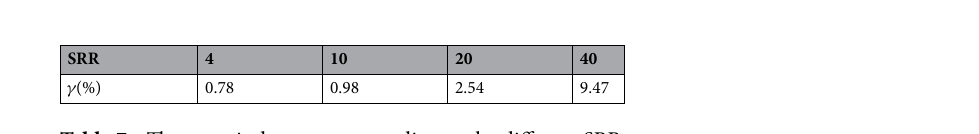
Table 7. The error indexes corresponding to the different